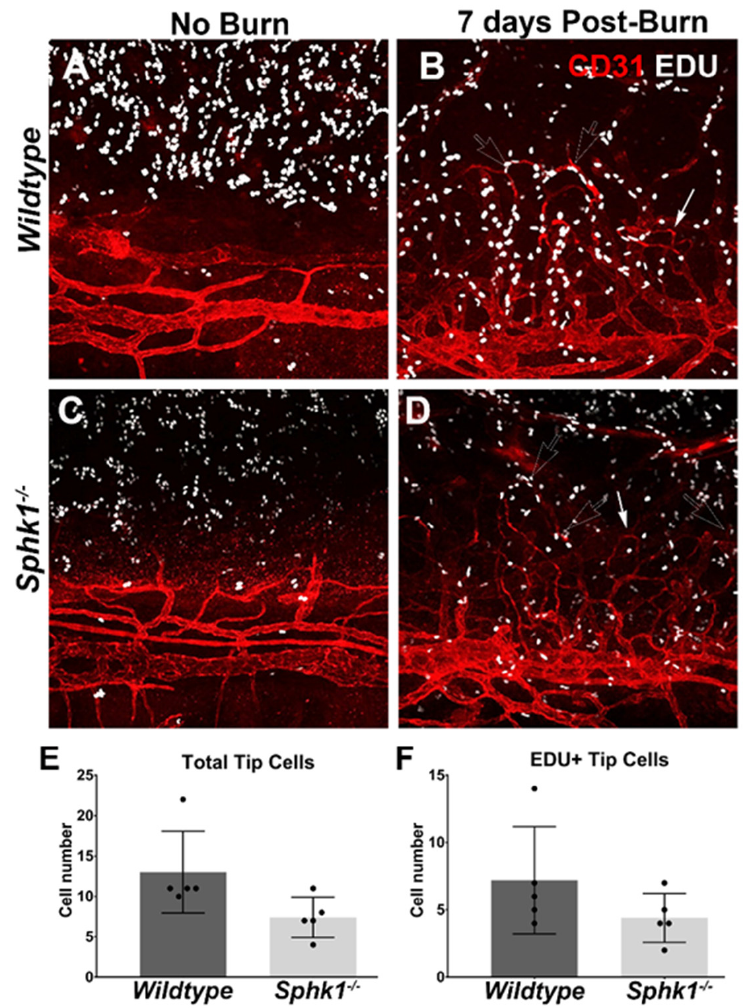
Figure 4. Ablation of Sphk1 does not affect the numbers of total and proliferating tip cells following alkali burn. WT and Sphk1 − / − mice corneas ( n = 5) were subjected to alkali burn. The mice were pulsed with EdU 5 days post burn (PBD), and corneas were collected on 7 PBD. Representative image showing WT ( A ) no-burn and ( B ) 7 PBD, and Sphk1 − / − ( C ) no-burn and ( D ) 7 PBD. Blood vessels are stained for CD31 (red), and proliferating cells are stained for EdU (pseudo-white). White-outlined arrowhead points to EdU-positive proliferating tip cells, and solid white arrowhead points to non- proliferating tip cells at the time of the EdU pulse. Quantitation of 7 PBD corneas showing ( E ) total tip cells and ( F ) EDU-positive tip cells. (Values are mean ± SD).